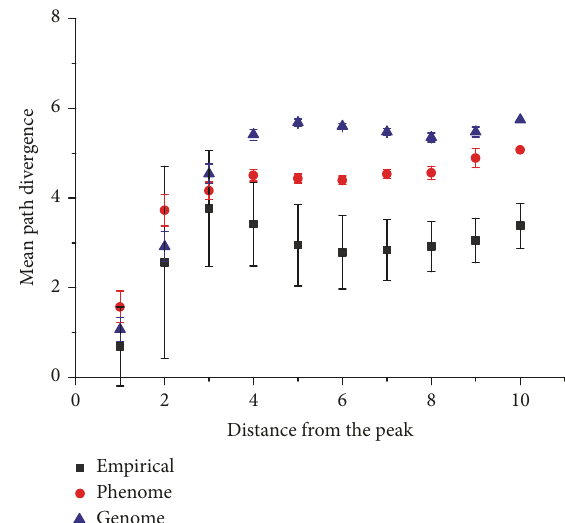
Figure 6: Comparison of mean path divergences among theoretical and empirical landscapes: mean path divergences, a measure of landscape smoothness, were compared between theoretical and empirical landscapes. The empirical landscape was binding data (black squares) for 10-base aptamers against the protein allophyco- cyanin [41]. The theoretical landscapes were genome-selected [34] (blue triangles) and the novel ones were phenome-selected (red circles), both with a string size of 𝑁 = 10 in order to correspond with the empirical dataset. The phenome selected landscape is more similar to the empirical